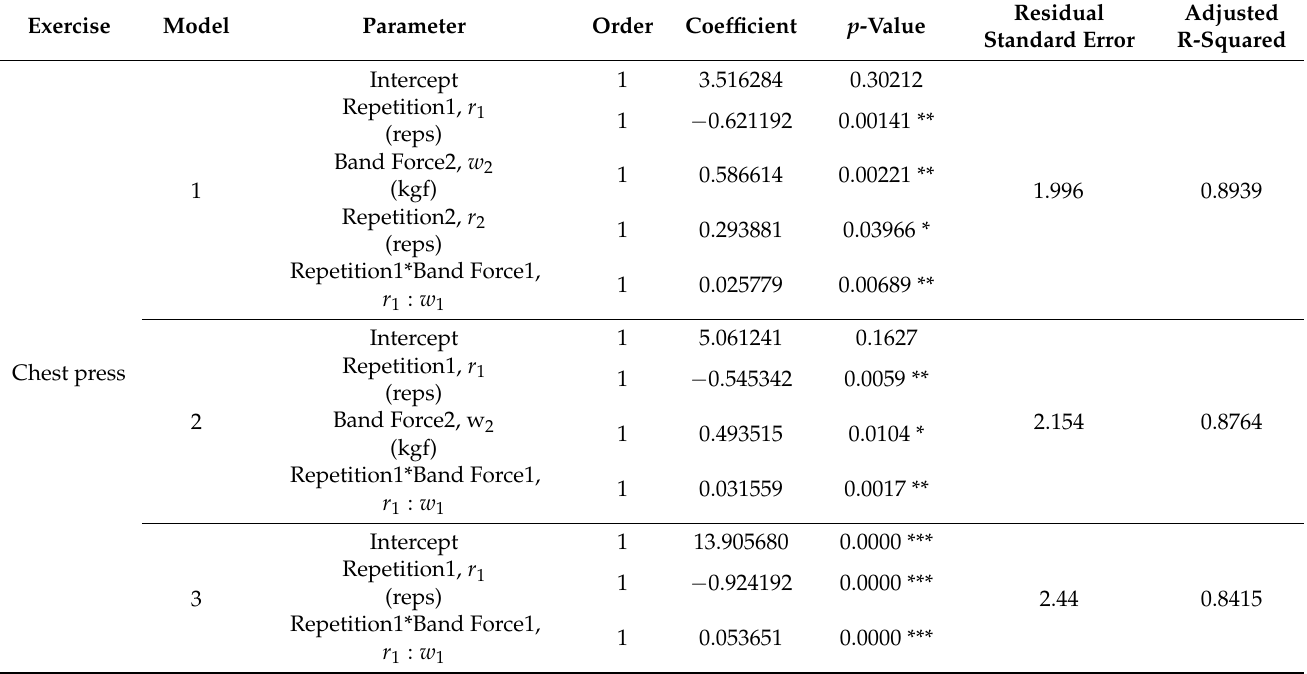
Table A1. Chest press 1 − RM equations and model reduction.